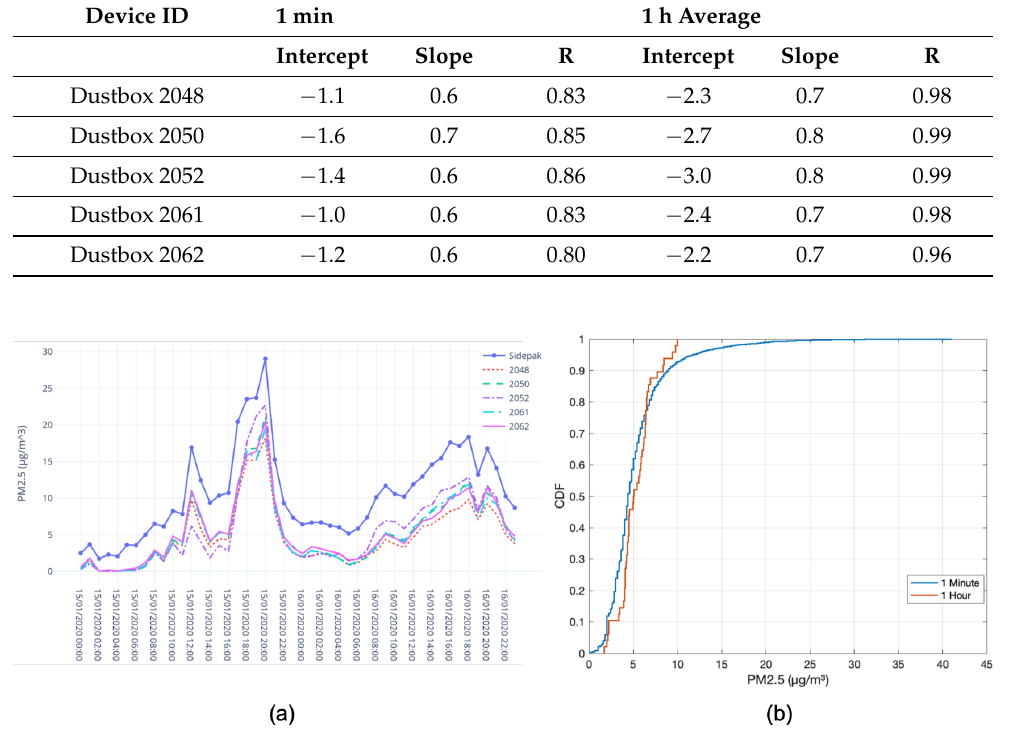
Figure 10. Performance comparison of Dustbox 2.0 and TSI AM520 for outdoor colocation: ( a ) line plot for hly data; and ( b ) CDF plot to understand the difference between the values recorded by Dustboxes and TSI AM520